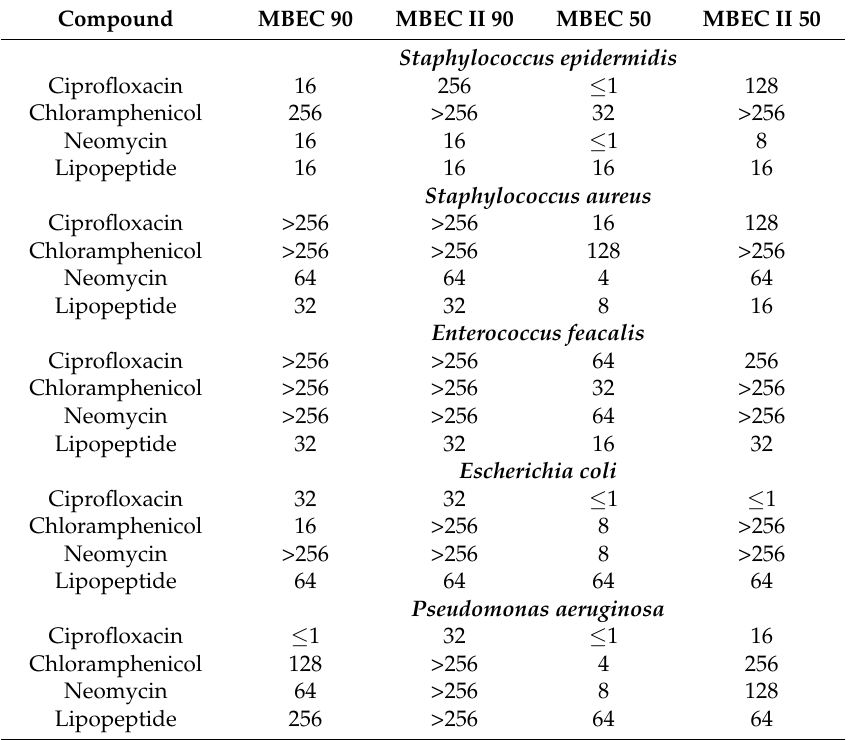
Table 1. Activities of conventional antimicrobials and the lipopeptide—(C 10 ) 2 -KKKK-NH 2 against bacterial biofilms formed on polystyrene plates presented as MBEC—minimum biofilm eradication concentration (mg/L); MBEC 90—the lowest concentration which allowed to reduce the metabolic activity of bacteria by at least 90 ± 5%; MBEC 90 II – the lowest concentration which resulted in permanent reduction of metabolic activity by at last 90 ± 5%; MBEC 50—the lowest concentration which allowed to reduce the metabolic activity by at least 50 ± 5%; MBEC 50 II—the lowest concentration resulted in permanent reduction of the metabolic activity by at least 50 ±